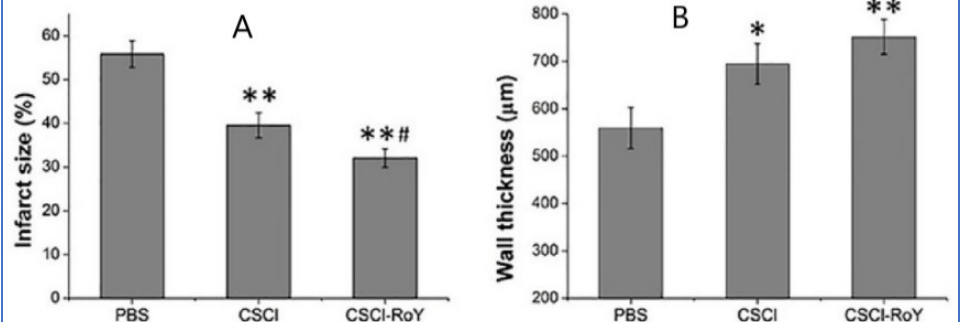
Figure 4. Impact of CSCL-RoY thermoresponsive hydrogel on myocardial infarction [31]. ( A ) Quantitative analysis of infarct size after the injections; ( B ) Quantitative analysis of infarct wall thickness (* p < 0.05 vs. PBS group, ** p < 0.01 vs. PBS group, # p < 0.05 vs. CSCl group).